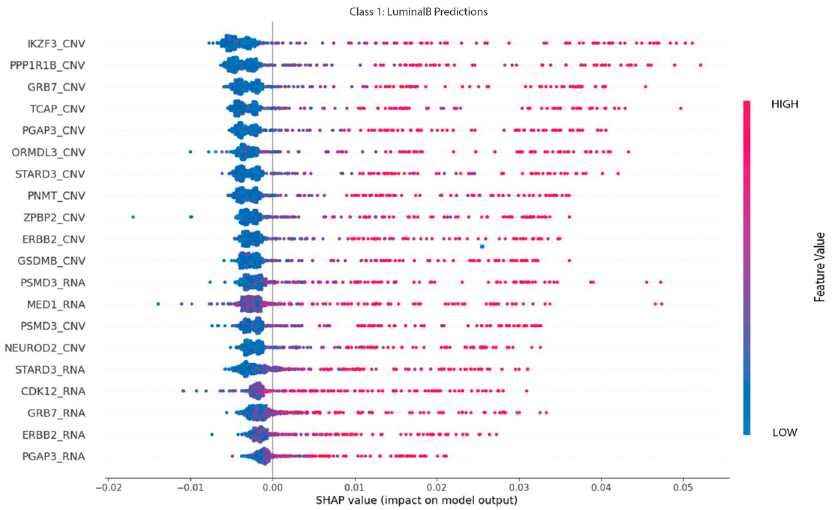
Figure 12. SHAP plot for luminal B prediction.